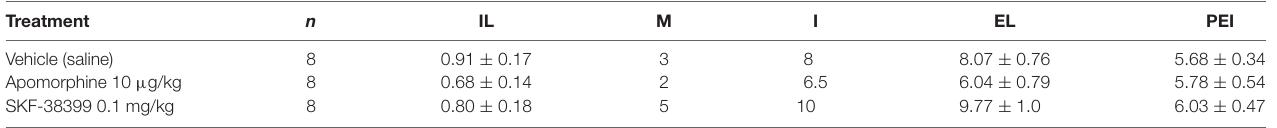
TABLE 1 | Specific sexual behavior parameters of the first copulatory series of sexually experienced male rats treated with specific doses of dopamine (DA) receptor agonists. Treatment n IL M I EL PEI